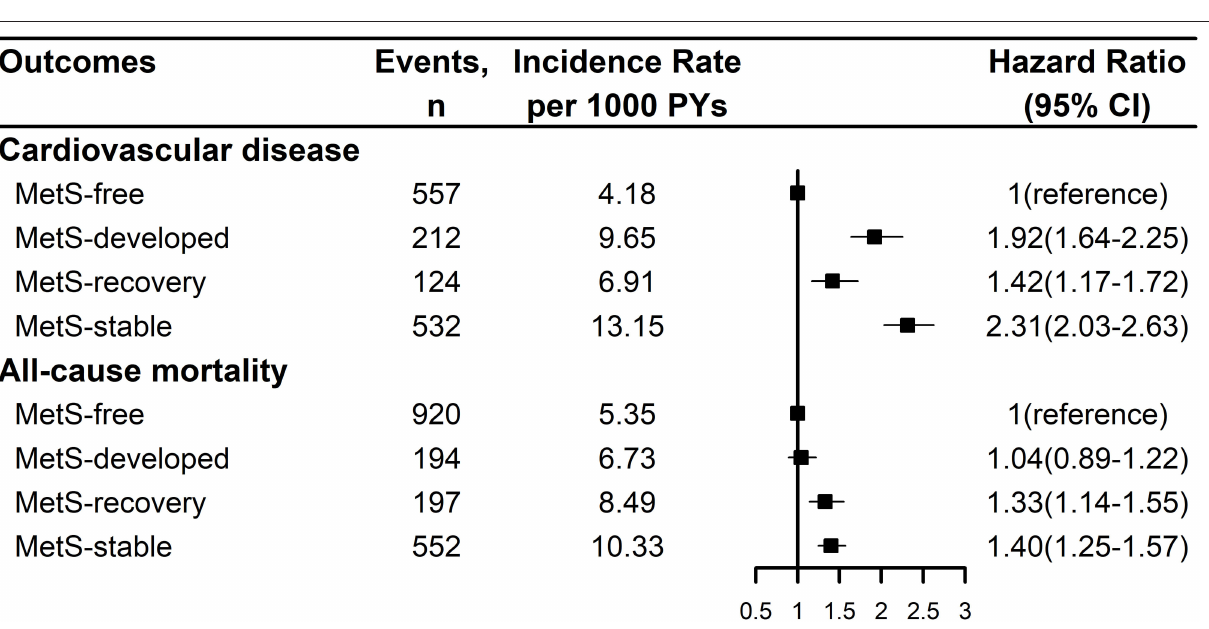
risks of CVD (HR = 0.38, 95% CI = 0.24–0.59) and all- cause mortality (HR = 0.68, 95% CI = 0.43–1.06) than those with late recovery ( Table 2 ). Significant interactions between MetS recovery and recovery age were found for CVD (